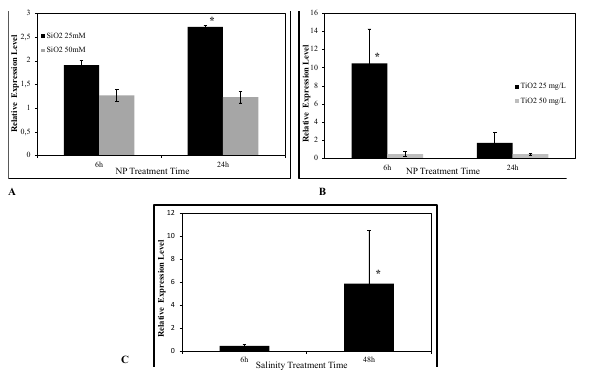
Fig. 8. Parthenolide concentration in Tanacetum parthenium leaves at different treatments.